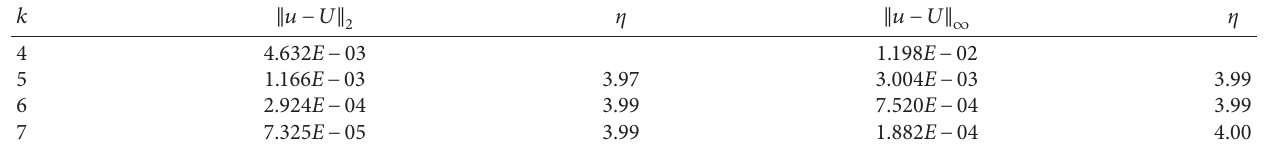
Table 1: The errors for finite difference solutions in two